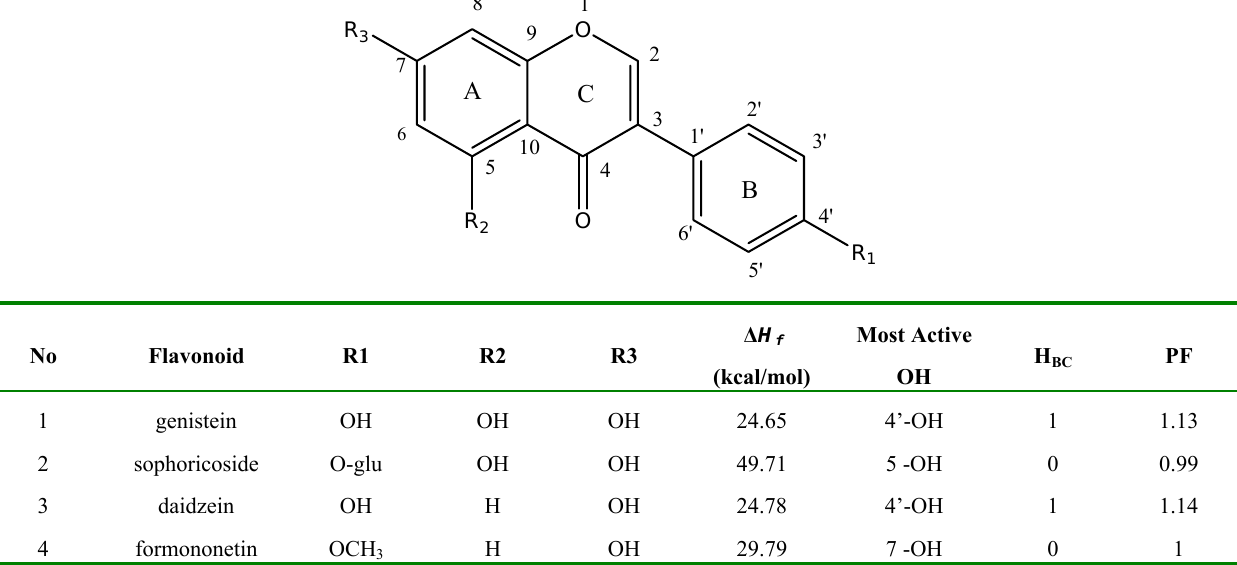
Table 3. Chemical structures, descriptors and antioxidant activity of some isoflavones